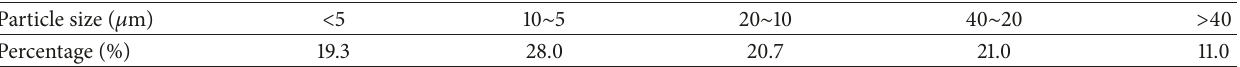
Table 7: Particle distribution of diatomite.